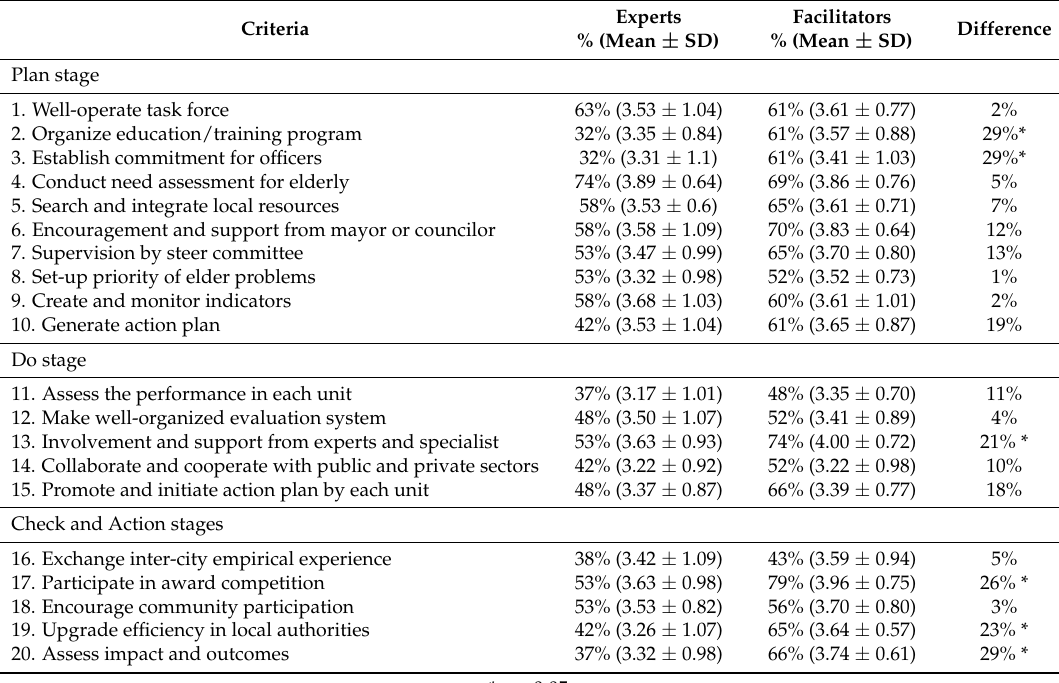
Table 1. Mechanisms and process ratings by experts and